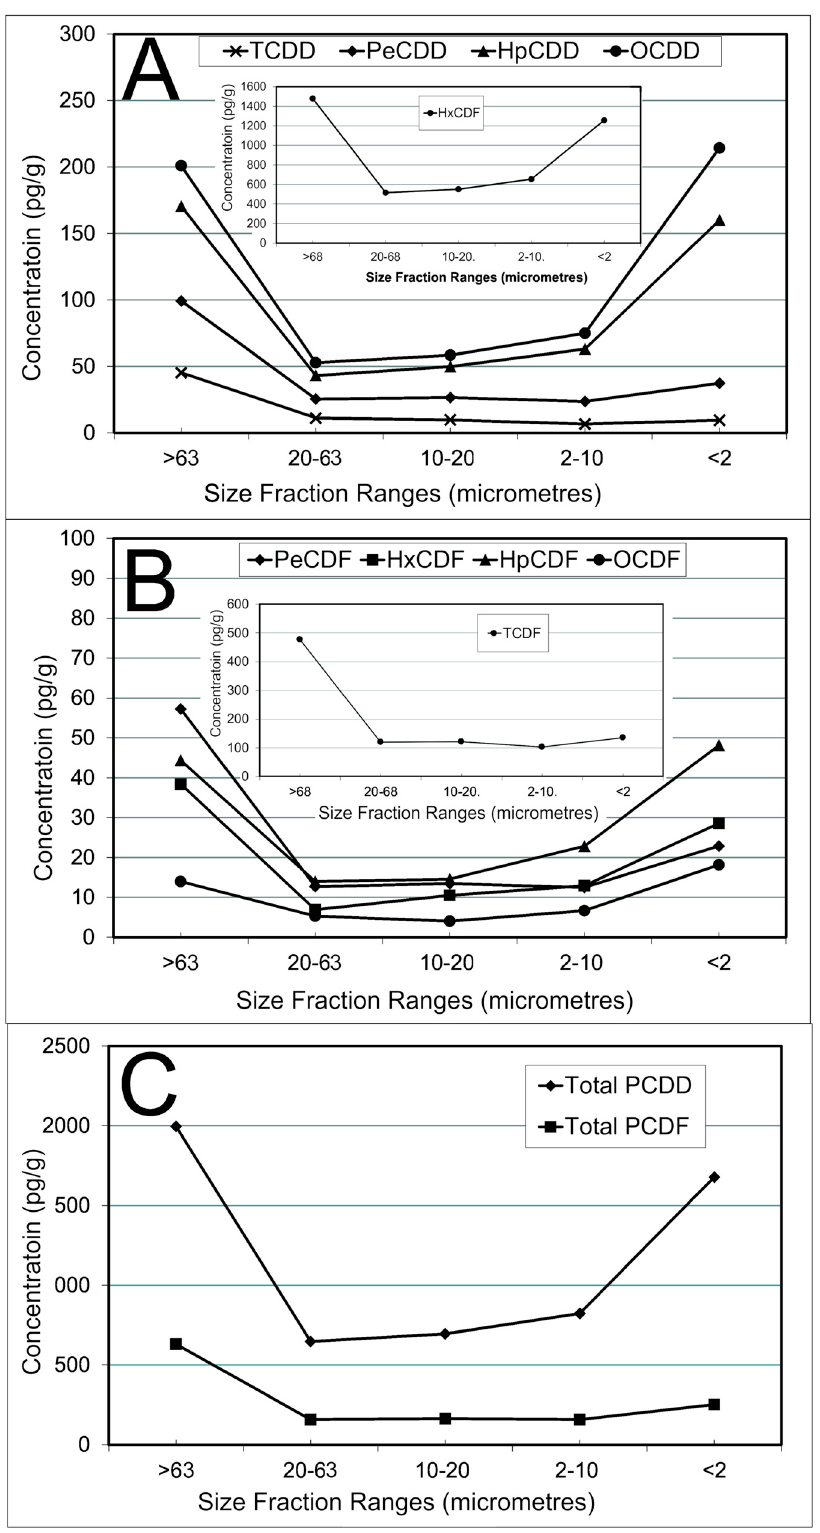
Figure 16. Plot showing the changes in concentration of dioxins ( A ), furans ( B ) and total homologues ( C ) between different size fractions at the 46–48cm depth interval. The majority of dioxin and furan homologues show significant increase in concentration in the finest three fractions. Insets show homologues, HxCDF and TCDF, present at concentrations significantly higher than other homologues.